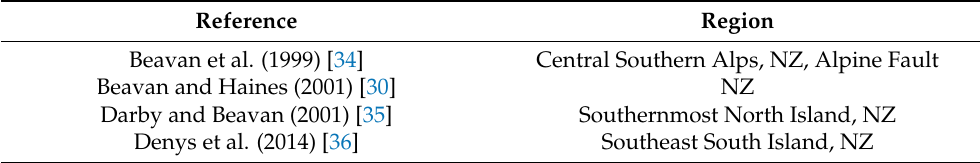
Table A1. Data from NZ GNSS campaigns used in constructing the GSS rate model.